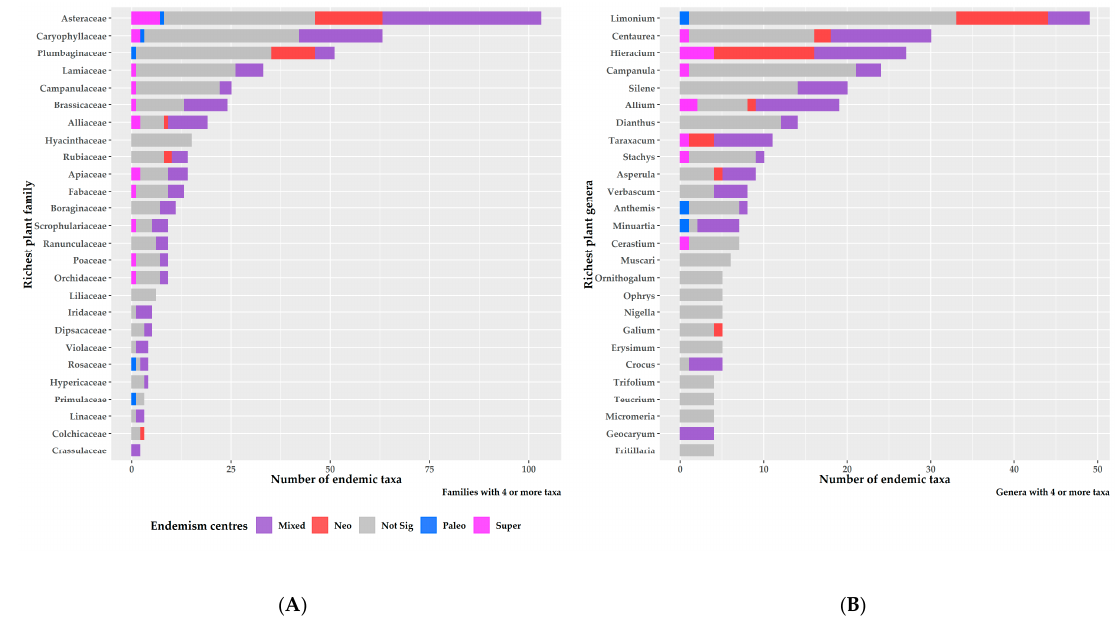
Figure 8. Richest plant families and genera [left ( A ) and right ( B ) panel, respectively] exclusively occurring in a single endemism centre type.